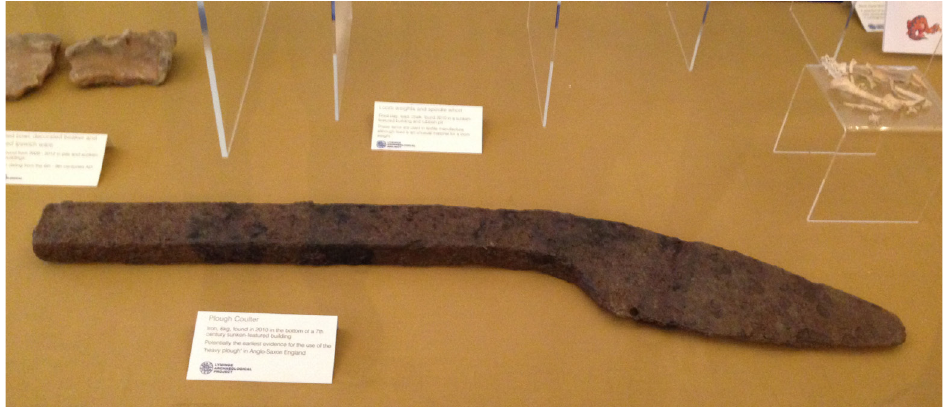
Fig. 1: The Lyminge coulter on display in Maidstone Museum (Photo: John